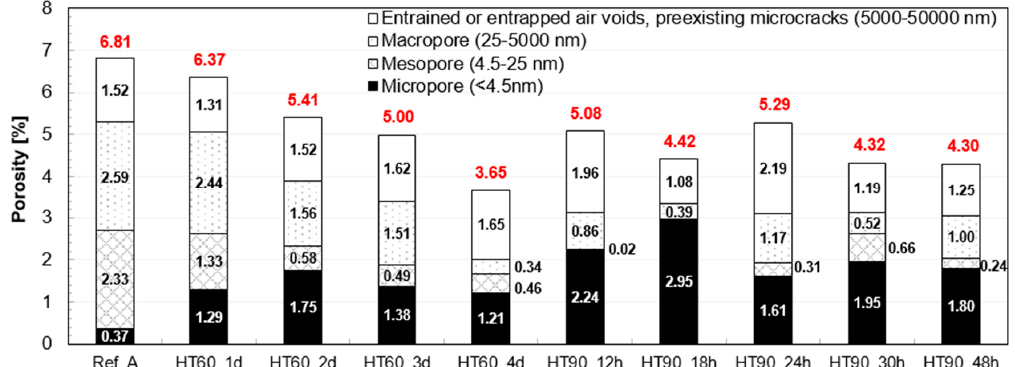
Figure 8. Pore volume distributions of UHPC at 28 days (Red numbers on the bars indicate the total porosity).